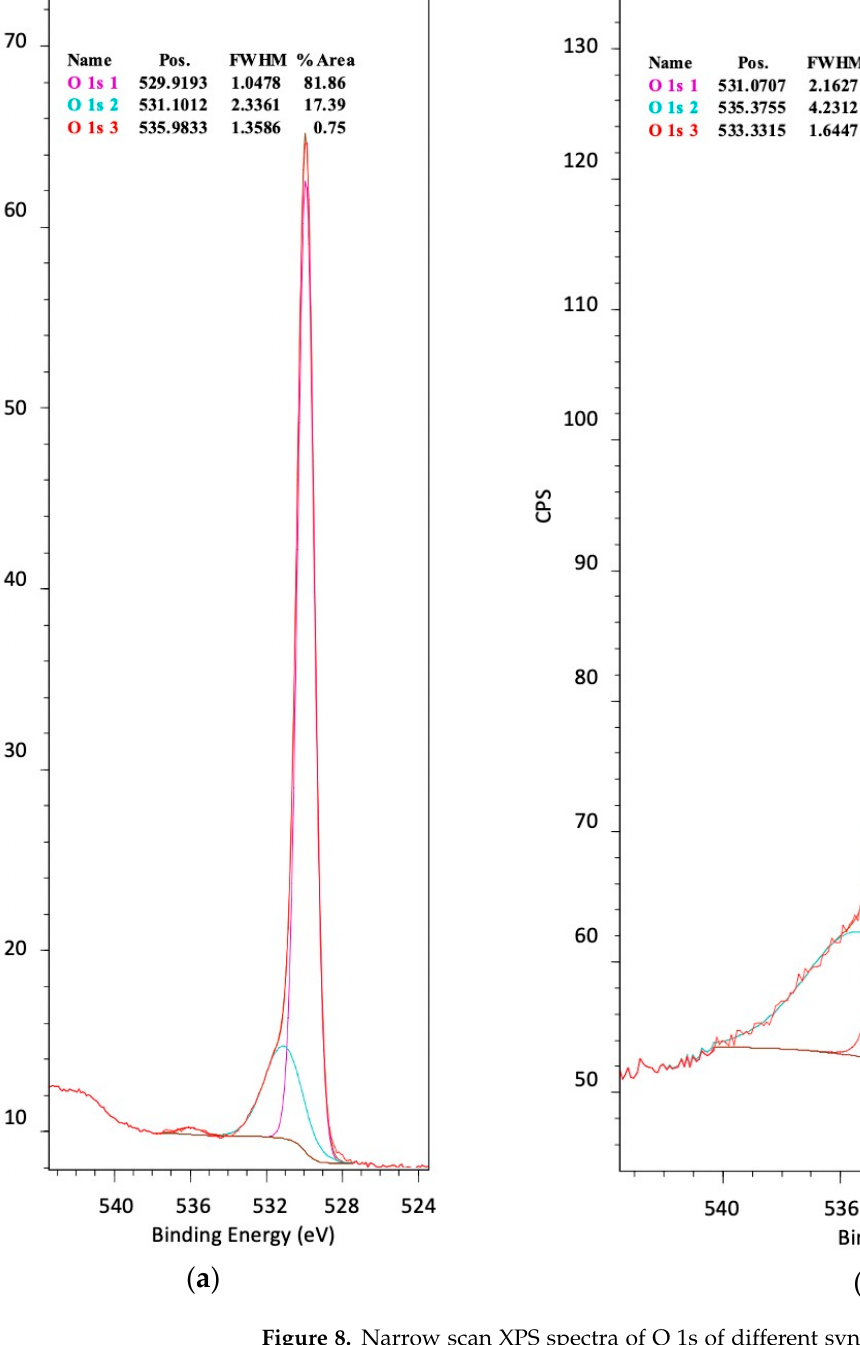
Figure 8. Narrow scan XPS spectra of O 1s of different synthesized materials: ( a ) N 4 /TiO 2 /rGO, ( b ) N 10 /rGO.